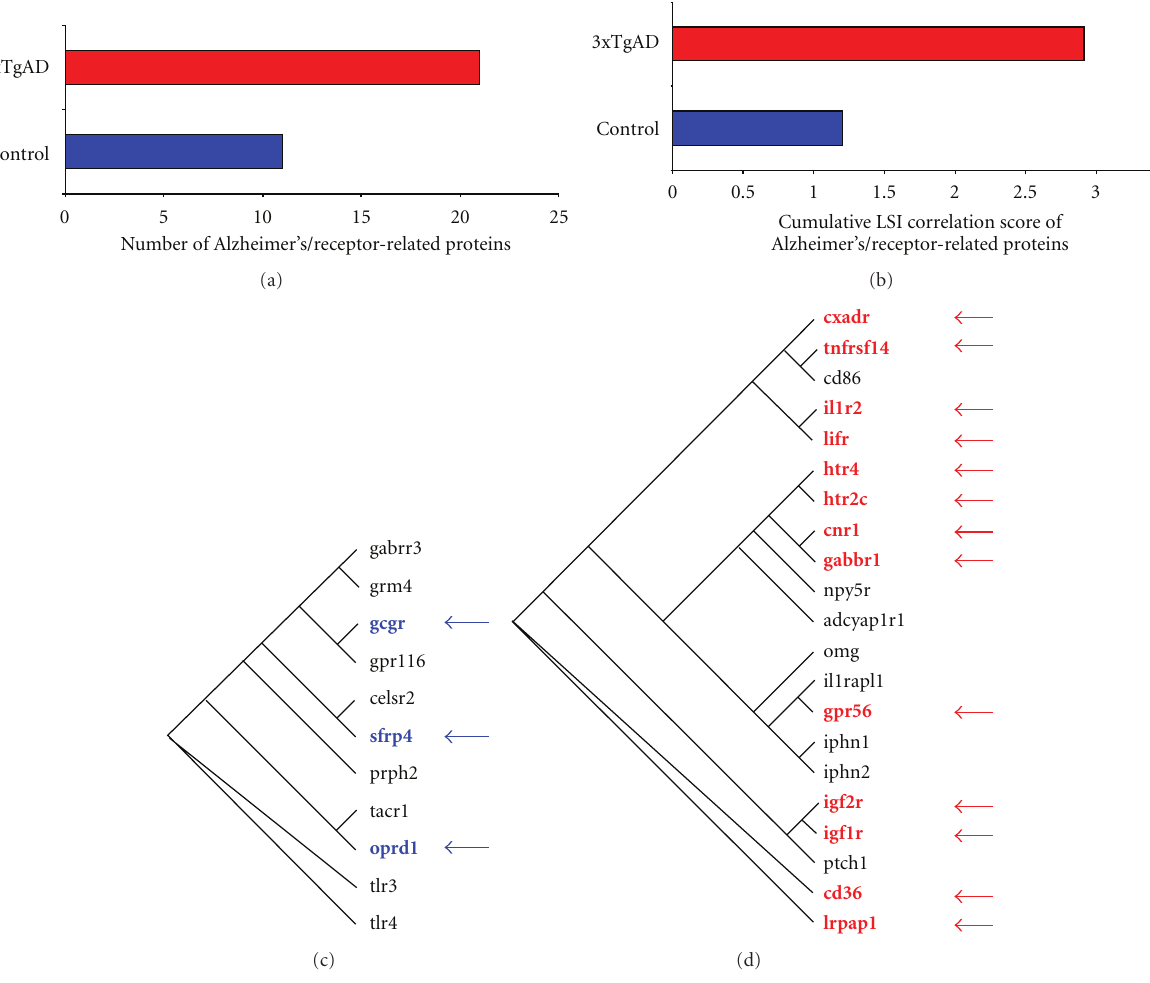
Figure 8: Alzheimer’s disease correlation of control or 3xTgAD receptor-specific lipid raft proteins. (a) The histogram represents the number of receptor-specific raft proteins (Table 1: control, Table 2: 3xTgAD) that demonstrate an explicit LSI correlation to the term “Alzheimer’s” for control (blue) or 3xTgAD (red) extracts. (b) The histogram depicts the cumulated LSI correlation scores for the Alzheimer’s-related receptor- specific proteins identified in (a). panels (c) and (d) represent the phylogenetic dendrograms for the receptor-specific raft proteins linked to the interrogation term “Alzheimer’s” from control (c) or 3xTgAD (d) datasets. The proteins highlighted in red or blue and indicated by an arrow were specifically clustered into the highest scoring protein interaction networks for control (Figure 7(b)) or 3xTgAD (Figure 7(c))